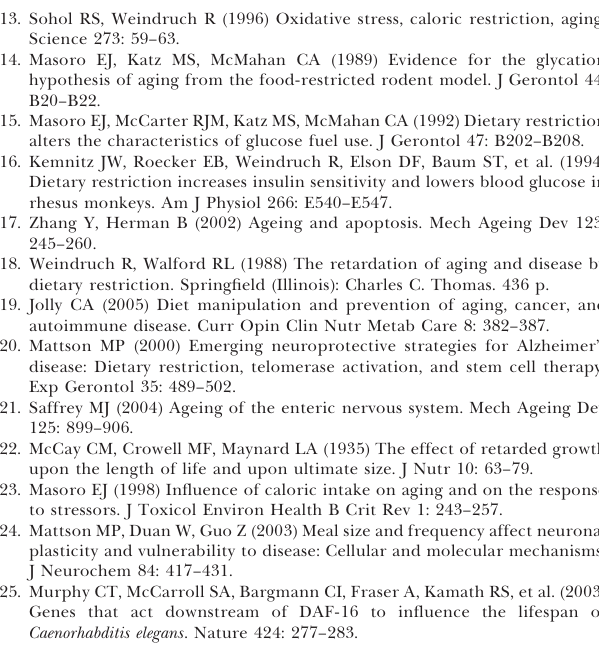
Figure S1. CR Has No Effect on Sir2 Activity in Respiratory- Competent or Respiratory-Deficient Cells Transcriptional silencing of the telomeric URA3 marker in PSY316- AUT was monitored by the survival of cells plated onto medium containing 5-FOA. Found at DOI: 10.1371/journal.pgen.0010069.sg001 (42 KB